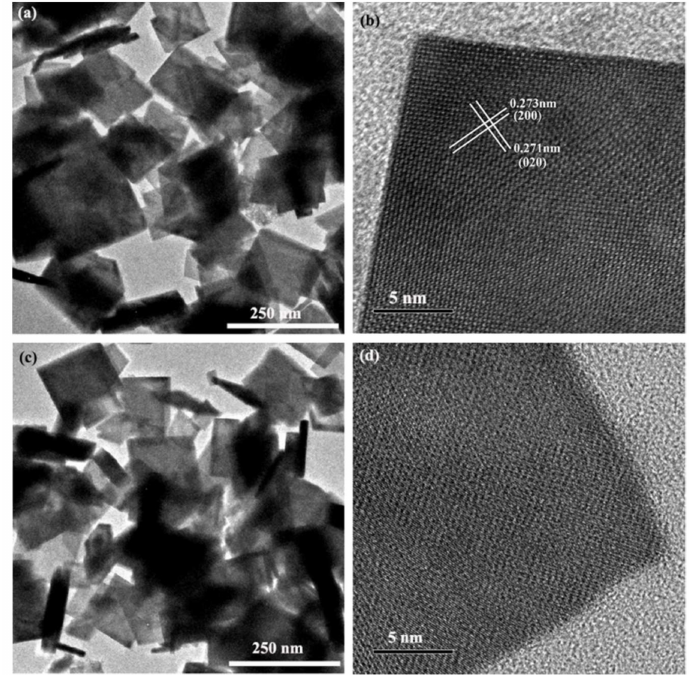
Figure 8. Transmission electron microscopy (TEM) images of ( a ) the pristine Bi 4 Ti 3 O 12 and ( c ) Bi 4 Ti 3 O 12 − x (350 ◦ C, 60 min); HRTEM images of ( b ) the pristine Bi 4 Ti 3 O 12 and ( d ) Bi 4 Ti 3 O 12 − x (350 ◦ C, 60